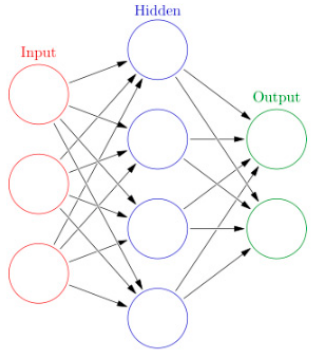
Figure 1. Three-layer neural network structure.